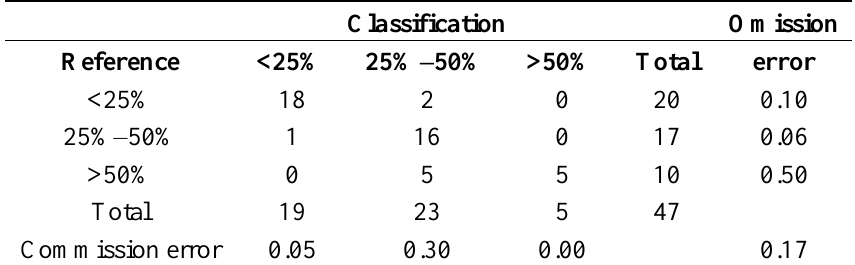
Table 5. Confusion matrix, model C (NDVI & differenced